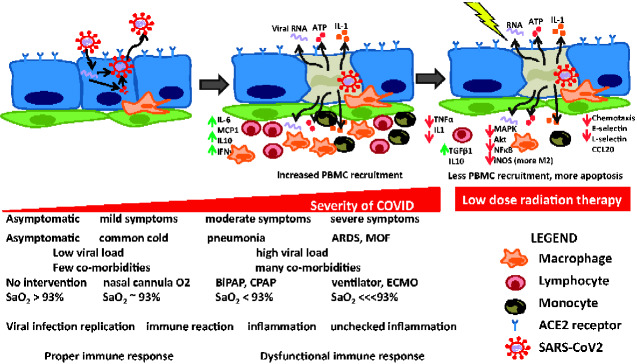
Schematic representation of viral infection, replication, and immune effects of Severe Acute Respiratory Syndrome-coronavirus-2 (SARS-CoV-2) infection and the possible mechanisms of low-dose radiation therapy. Depicted on the top are cartoons of lung epithelial cells in blue, endothelial cells in green, and resident macrophages in orange. The cartoon on the left illustrates early infection by the virus (red circle with spikes), internalization, replication, reformation, and release. In the middle is a depiction of release of pathogen-associated molecular pattern (PAMP) hallmarks, including ATP, viral RNA, and interleukin-1 (among others); destruction of the infected cell (now gray); and recruitment of peripheral blood mononuclear cells (PBMCs), adherence to endothelial cells during this chemotaxis, and elaboration of host of proinflammatory cytokines (green arrows). On the right is a depiction of potential consequences of low-dose radiation of this immune-dysregulated lung microenvironment where there is less PBMC recruitment, less chemotaxis, less endothelial adherence because of downregulation of E/L-selectins, more apoptosis and less proliferation of recruited PBMCs, and a shift in the proinflammatory cytokine milieu towards more of an anti-inflammatory one. Also depicted on the bottom panel are features of COVID as the severity of disease increases (from left to right): clinical manifestations, interventional approaches, and viral and immune responses. ACE2 = angiotensin converting enzyme 2; ARDS = acute respiratory distress syndrome; BiPAP = bilevel positive airway pressure; CPAP = continuous positive airway pressure; ECMO = extracorporeal membrane oxygenation; MOF = multi-organ failure; SaO2 = oxygen saturation.